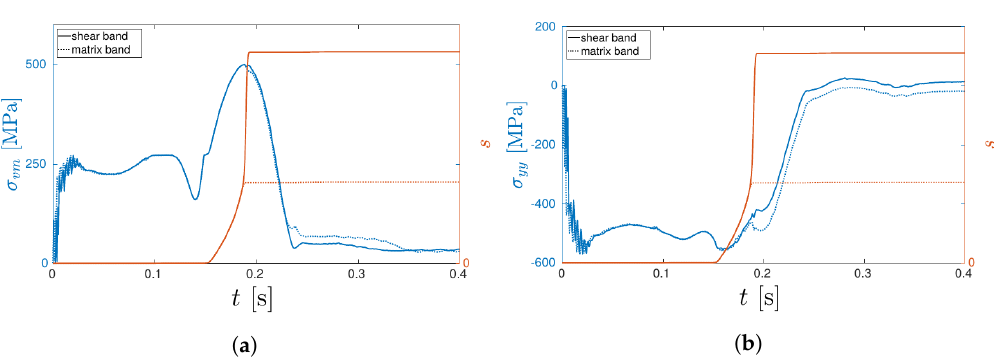
Figure 16. The evolution of the effective plastic strain s (orange) and of ( a ) the von Mises equivalent stress (blue) and of ( b ) the principal stress in ECAP pressure direction (blue). The solid lines are used for the shear band and the dotted lines for the matrix